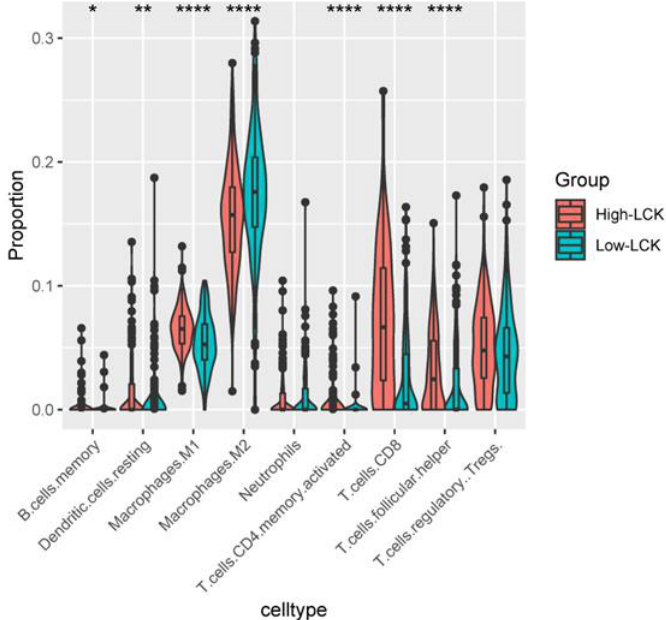
Figure 9. TCGA data, CIBERSOFT was used to calculate the infiltration of immune cells in each sample, and the R package ggplot2 was used for visualisation. The rank sum test was used to explore the differences in TILs between the high and low LCK expression groups. p < 0.0001 = ****, p < 0.01 = **, and p < 0.05 = *.